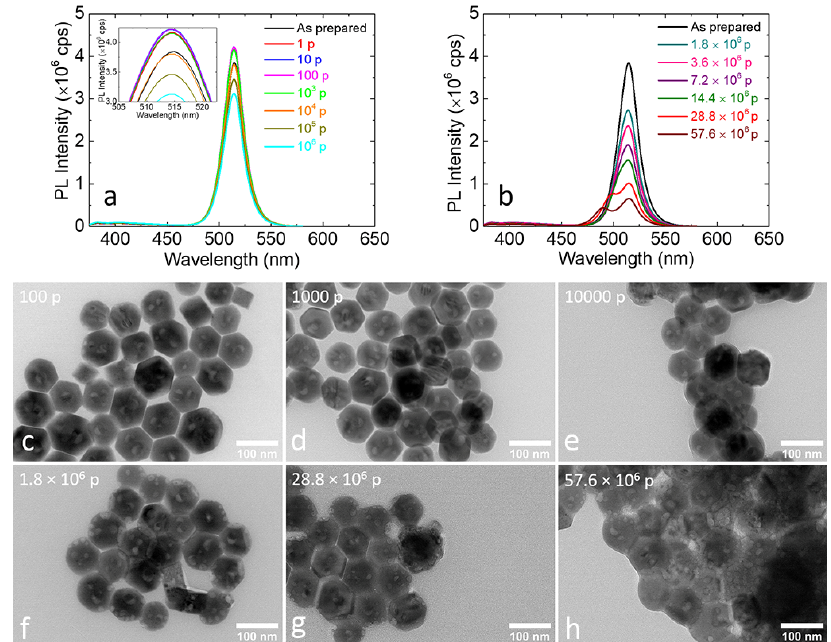
Figure 3. Photoluminescence spectra of the metal halide perovskite nanohexagons dispersed in DCB and irradiated with a laser fluence of 0.5 mJ/cm 2 and number of pulses from single to 10 6 ( a ) and from (1.8 to 57.6) × 10 6 pulses ( b ). Representative low-magnification TEM images of the irradiated nanocrystals for different number of pulses ( c – h ). The irradiation was carried out with a femtosecond laser of 513 nm